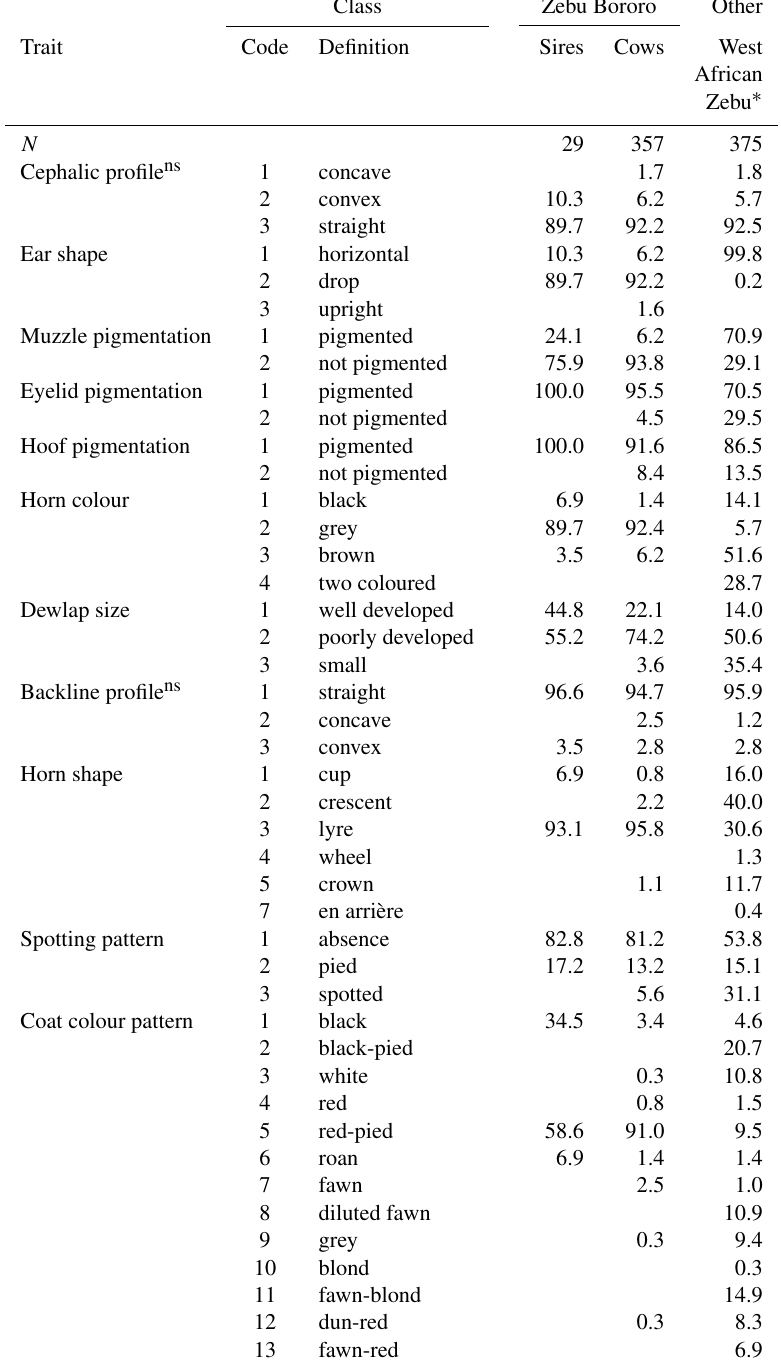
Table 4. Frequencies (in percentage) of each level of the 11 qualitative traits assessed in Zebu Bororo sires and cows. Additionally, frequen- cies observed in four other West African zebu populations, comprising a total of 311 cows and 64 sires, for the same traits are given as a